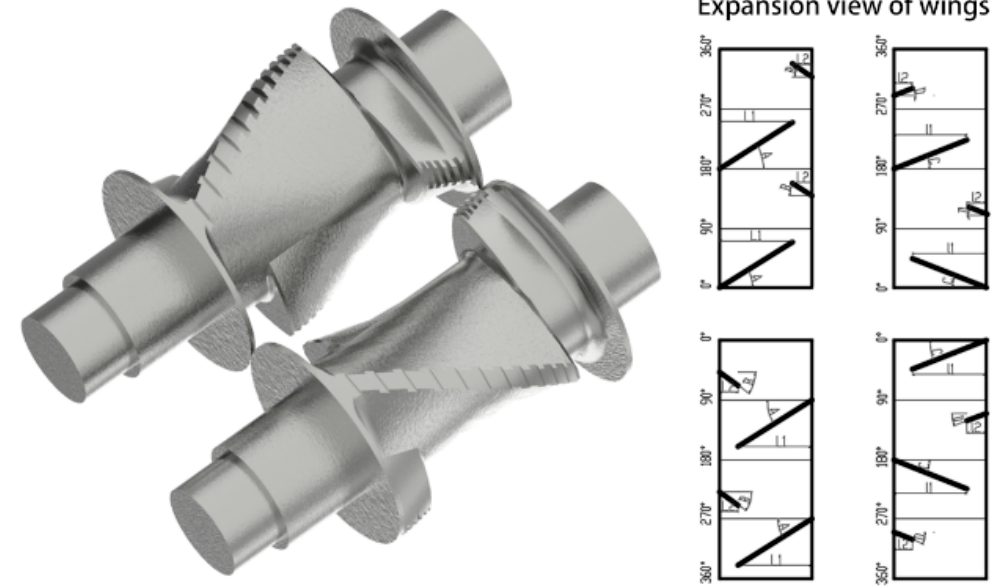
Figure 2. Integral structure of the serial modular continuous mixer.